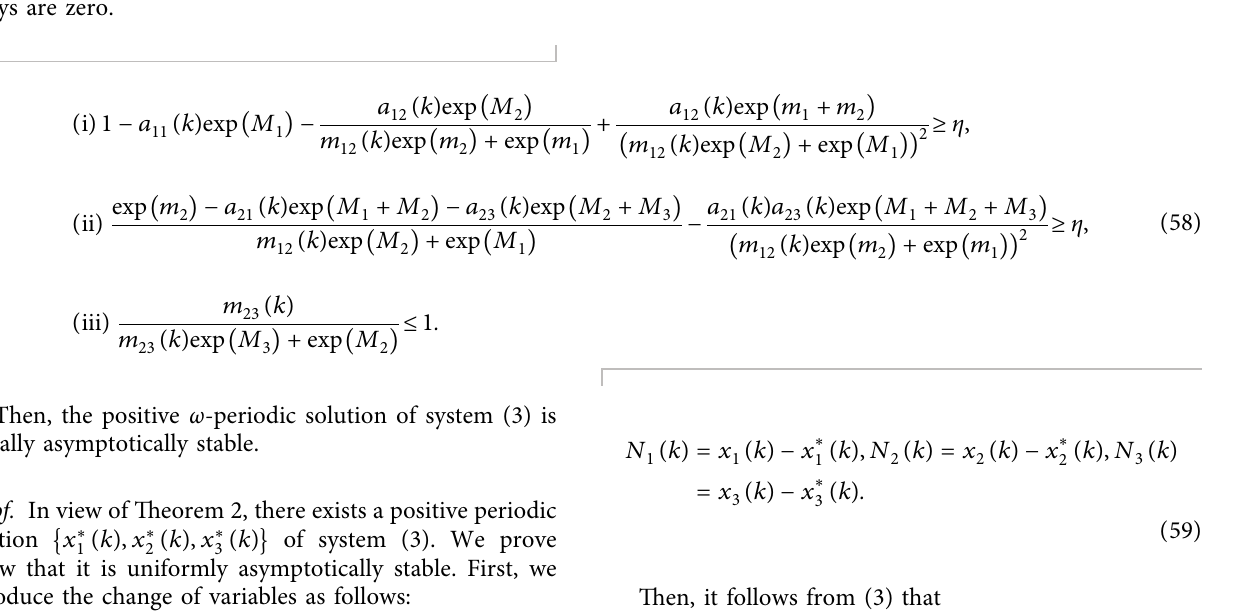
Figure 1: The time histories of t − x represents x